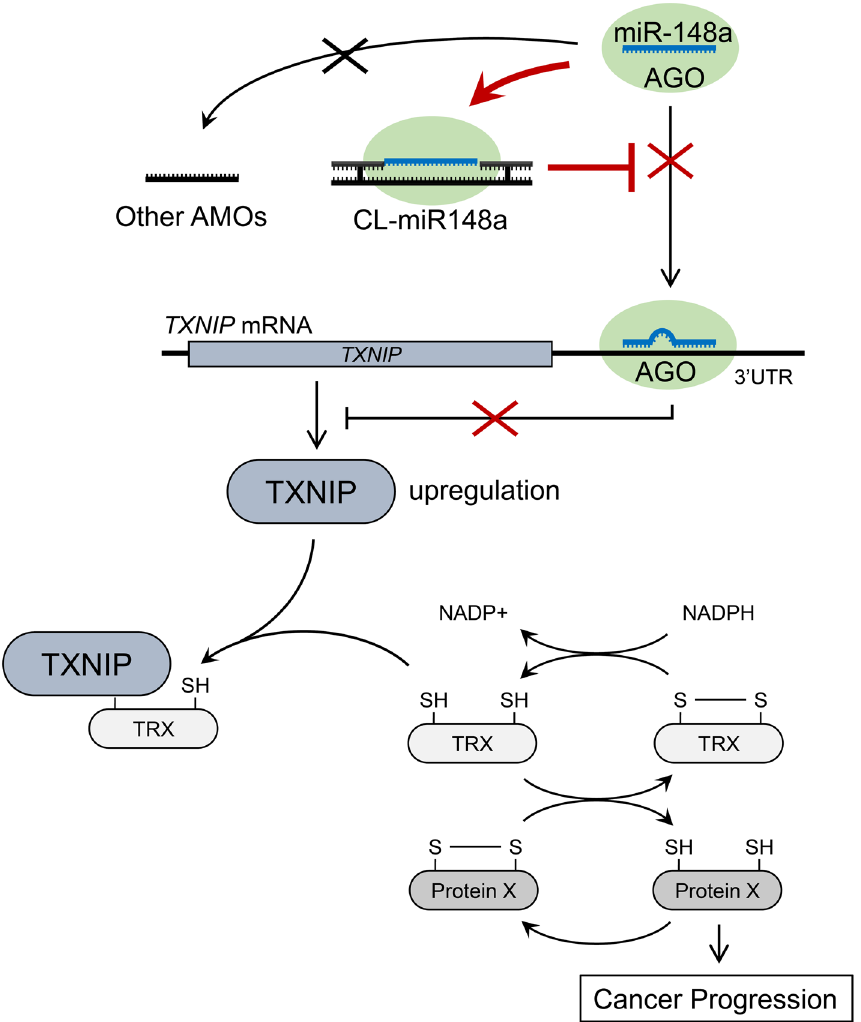
Figure 6. Schematic diagram of CL-miR148a-mediated inhibition of BC cell proliferation. The reduced form of TRX (thioredoxin) displays an antioxidant activity by reducing the oxidized protein X. This antioxidant function is associated with cancer progression. TXNIP binds to reduced TRX and prevents protein X reduction, resulting in the inhibition of tumorigenesis in BC. TXNIP expression is regulated by miR-148a binding to the 3 ′ -UTR of the mRNA. CL-miR148a antagonizes miR-148a binding to TXNIP mRNA, resulting in the upregulation of TXNIP expression. By contrast, other AMOs could not stably sequester miR-148a. The red X marks the steps inhibited by the addition of